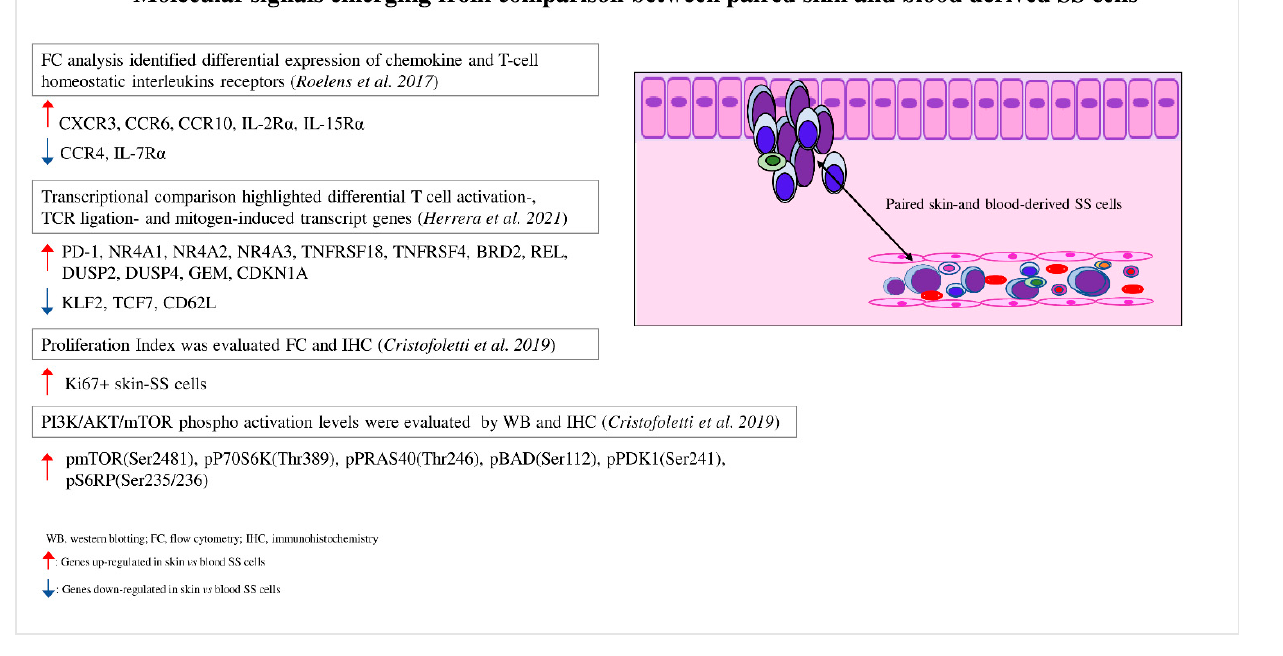
Figure 1. Molecular signals emerging from comparison between paired skin ‐ and blood ‐ derived SS cells. Comparison analyses performed between paired skin ‐ and blood ‐ derived SS cells highlight the molecular signals triggered in these two SS cell subpopulations.